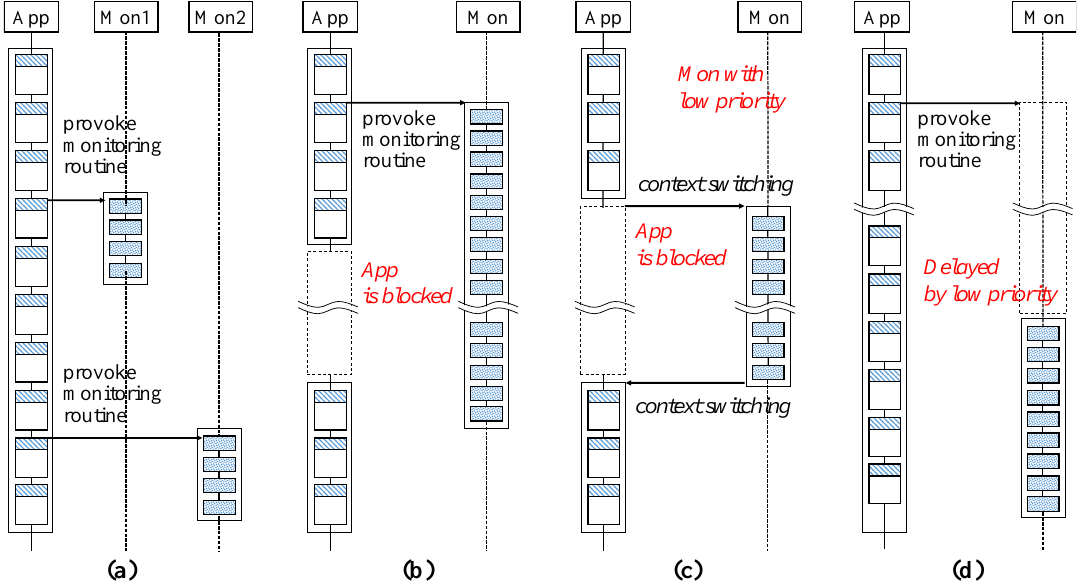
Figure 7. Monitoring scenario with SSCFM: ( a ) separate signature-based monitoring (SSCFM) scheme ( Q = 4, C ≥ 2); ( b ) I/O blocking with SSCFM ( Q = 50, C ≥ 2, B = True); ( c ) I/O blocking with SSCFM ( Q = 50, C = 1, B = True); and ( d ) delayed CFE monitoring with SSCFM ( Q = 50, C ≥